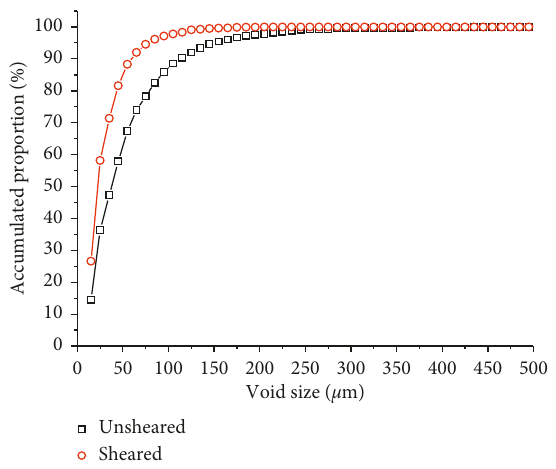
Figure 10: Average pore size distribution with height.